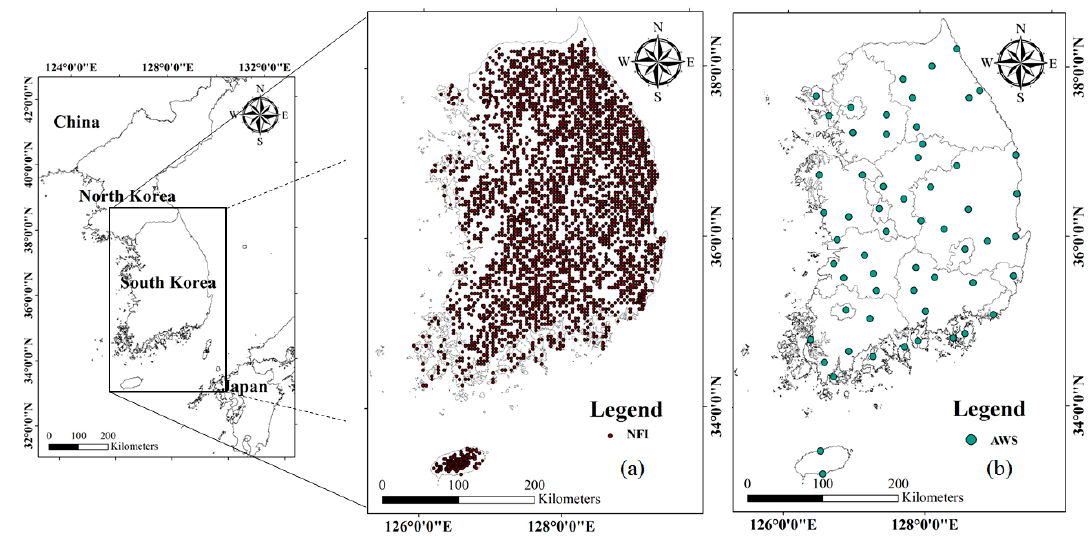
Figure 1. Study area with permanent plots of the Korean National Forest Inventory (NFI) ( a ) and automated weather station (AWS) points ( b ).